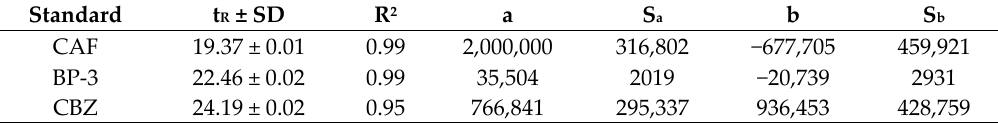
Table 3. Parameters of calibration curves for determining micropollutants by GC-MS. Standard